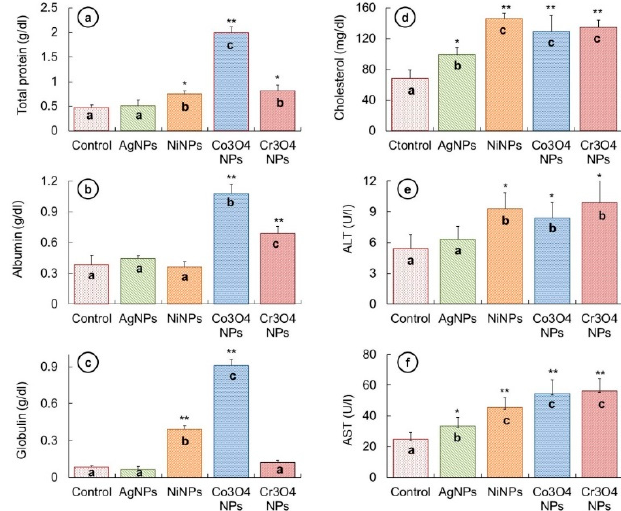
Figure 8. ( a ) Total protein was found to be significantly high in NiNP-, Co 3 O 4 NP-, and Cr 3 O 4 NP-treated fish. ( b ) Albumin was significantly high in Co 3 O 4 NP- and Cr 3 O 4 NP-treated fish groups in comparison to the control. ( c ) The globulin value was significantly high in NiNP- and Co 3 O 4 NP-treated fish than control. ( d ) Cholesterol level was significantly high in all treated groups. ( e ) ALT concentration was significantly high in NiNP-, Co 3 O 4 NP-, and Cr 3 O 4 NP-treated groups in comparison to the control. ( f ) Concentration of AST was significantly high in all treated groups than control. Columns showing different letters (a, b, and c) are significantly different, (* p < 0.05) (** p <